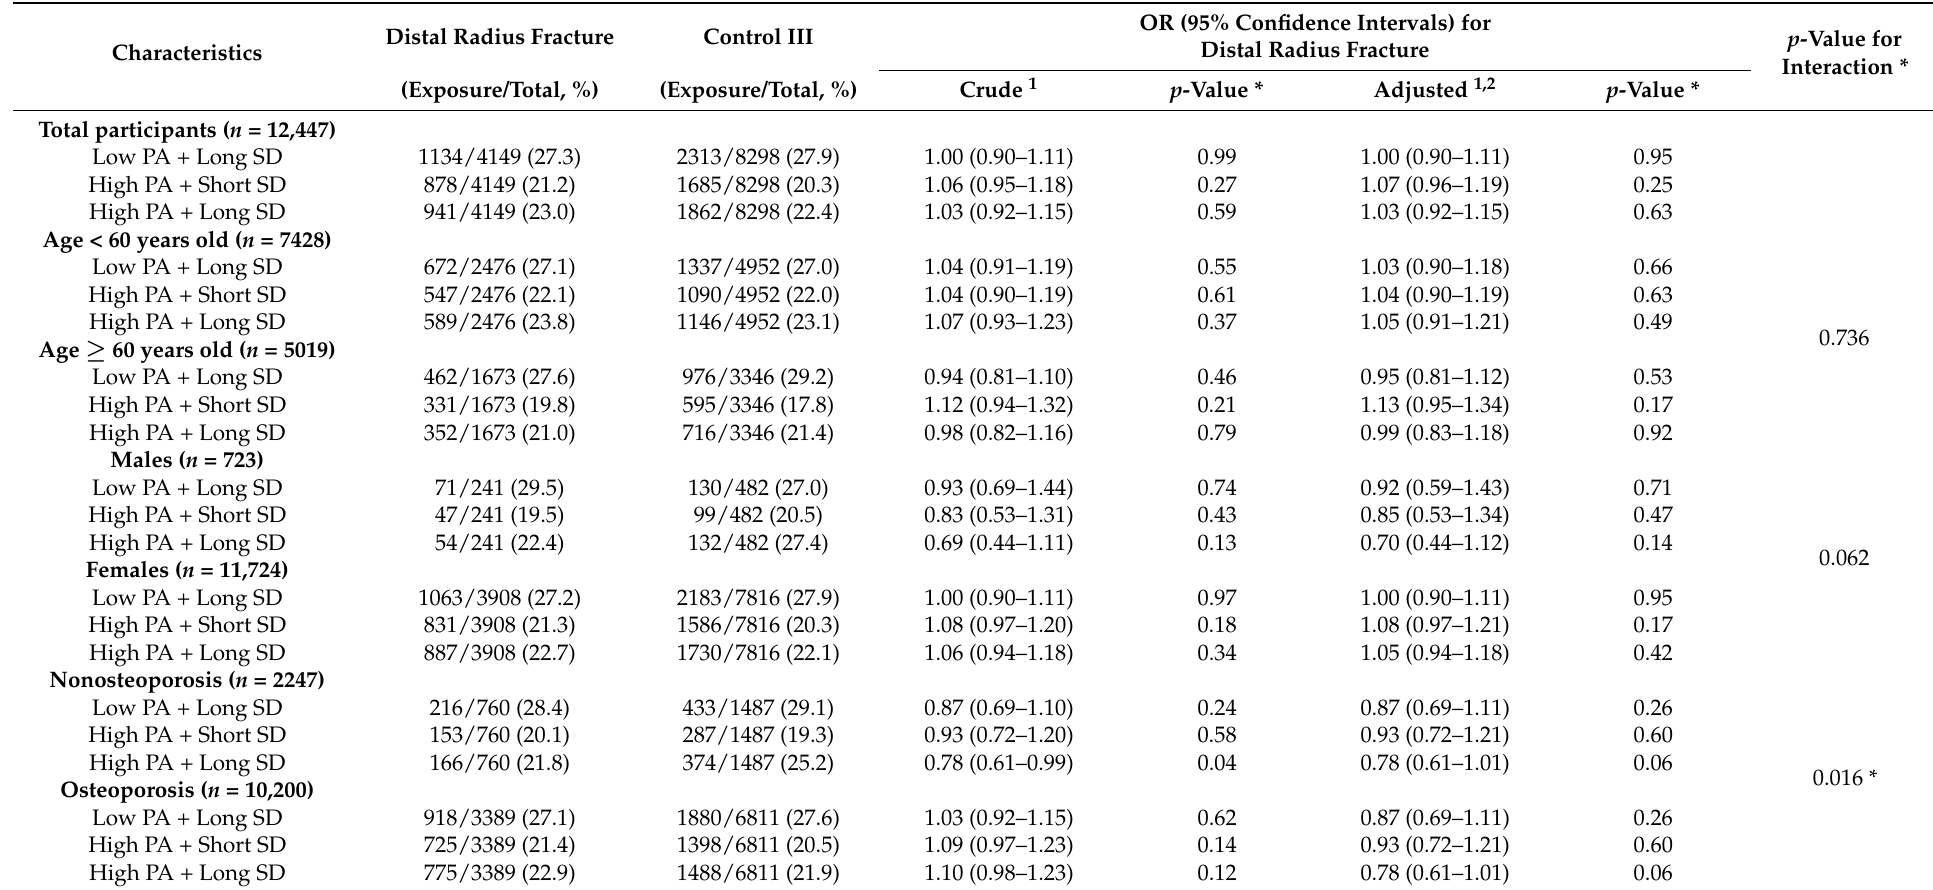
Table 4. Odds ratios (95% confidence intervals) of physical activity and sunshine duration for distal radius fracture with subgroup analyses according to age, sex, and osteoporosis history (reference: Low PA + Short